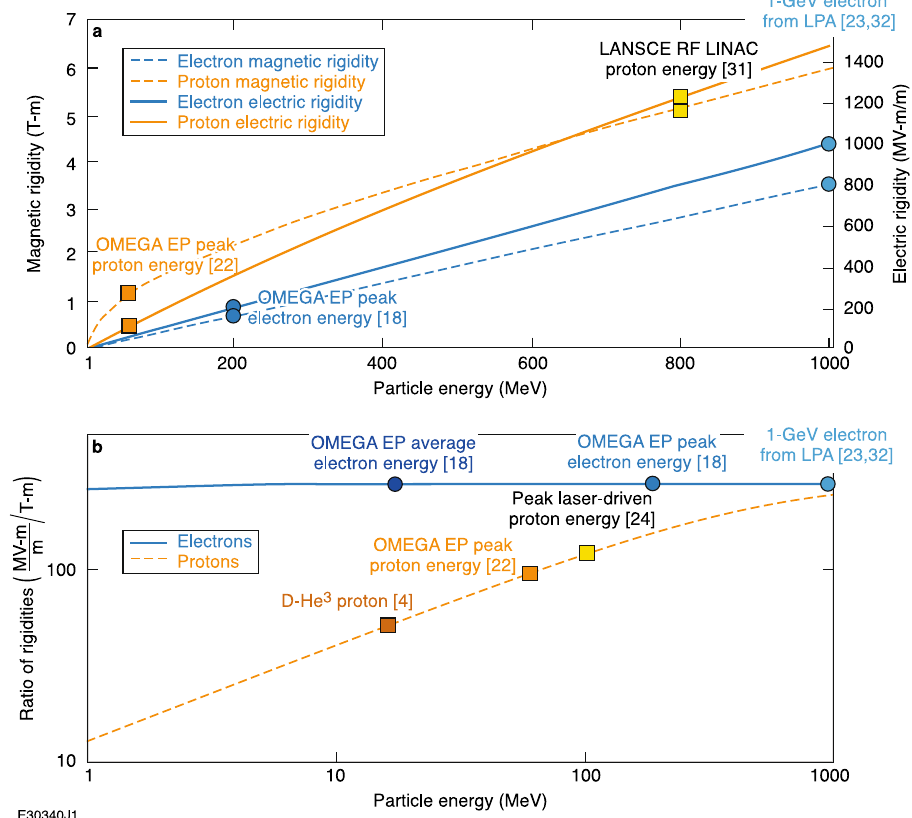
Figure 2. ( a ) Magnetic and electric rigidity of protons and relativistic electrons up to 1 GeV. ( b ) The ratio of rigidities for selected laser-driven proton and relativistic electron sources, with a focus on OMEGA EP because of its common use as a proton source for HED and LPI